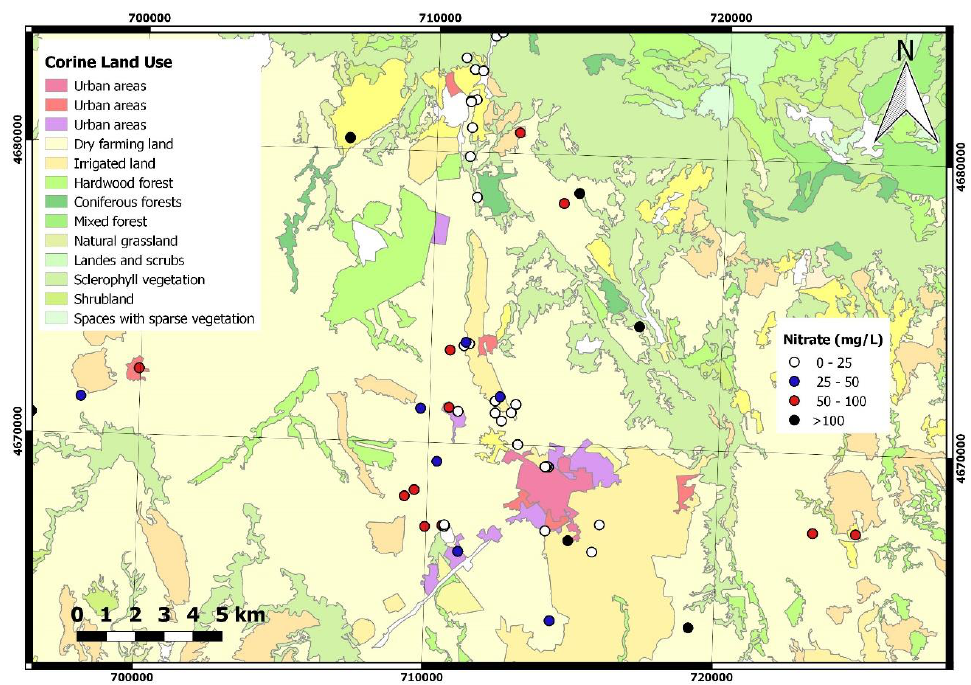
Figure 5. Nitrate contents in groundwater and land use in the Hoya de Huesca aquifer on a CORINE land cover (EEA) layer. Irrigated areas around Huesca city, in the center of the figure, do not have enough water for crops like maize and lucerne.